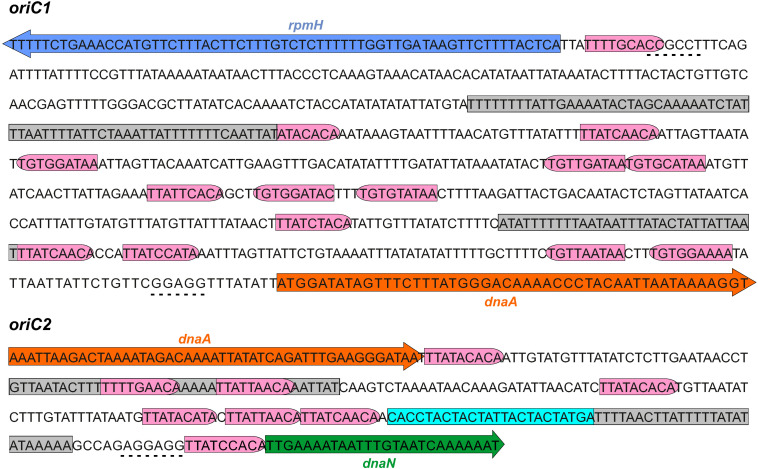
Identification of the C. difficile oriC region. Nucleotide sequence of the oriC1 region (nucleotide 4292328 to 48 of the C. difficile 630Δerm LN614756.1 genome sequence) and oriC2 region (nucleotide 1274 to 1587). Identification of the possible unwinding AT-rich regions previously identified in the SIDD analysis (gray boxes). The putative DnaA boxes found are represented (pink boxes) and orientation in the leading (right) and lagging strand (left) are shown. Possible DnaA-trio sequence are denoted (light blue boxes). Coding sequence of the genes rpmH (blue arrow), dnaA (orange arrow) and dnaN (green arrow) and respective putative ribosome binding sites (dashed line) are indicated. Pattern identification is described in section “Materials and Methods.”